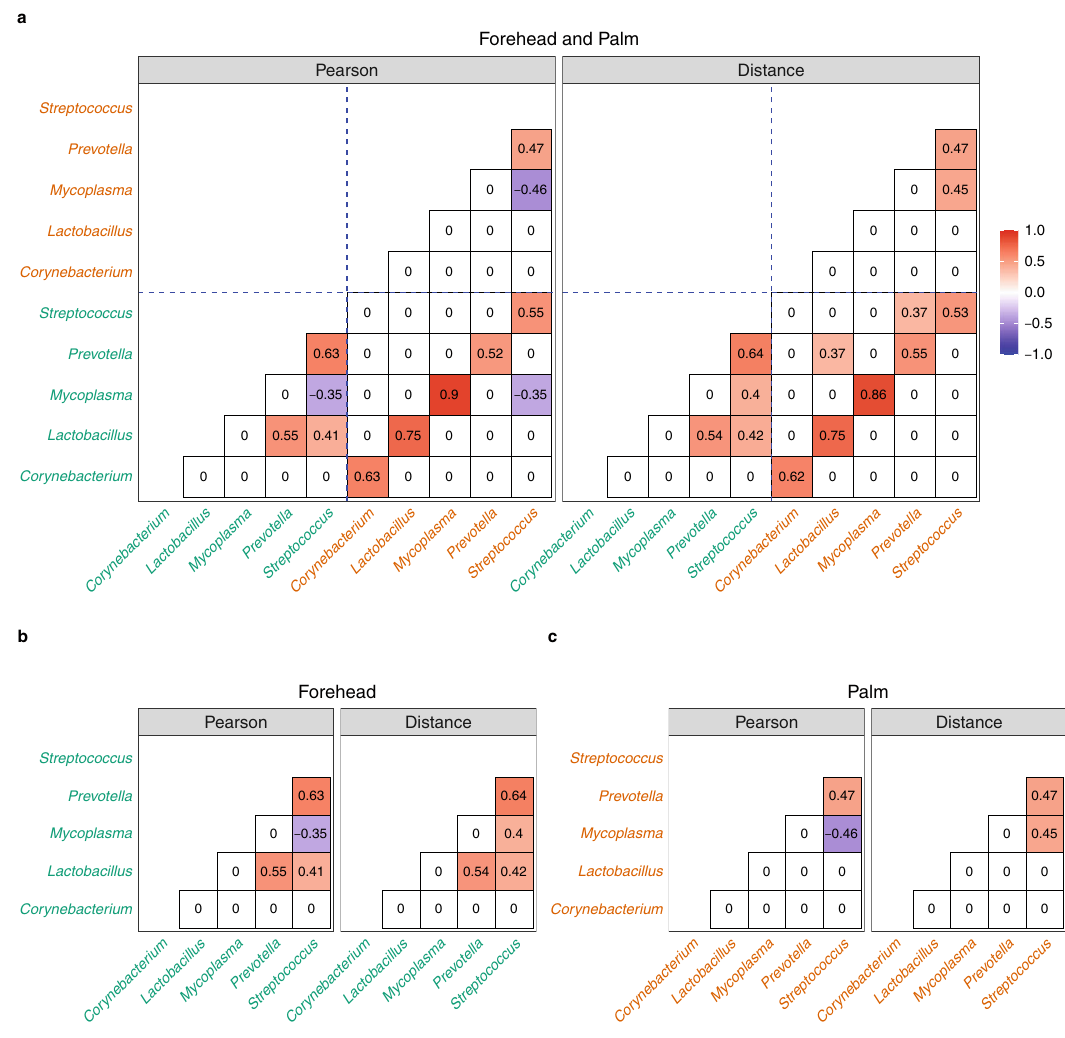
Fig. 5 | Correlations between forehead and palm genera 37 using SECOM. a Correlation matrices calculated by concatenating forehead and palm data, b Correlation matrices calculated using the forehead data alone, c The correlation matrices calculated using the palm data alone. The correlation measures (Pearson andDistance)arerepresentedbycolumns.Thetop fi vemostabundantgenerawere